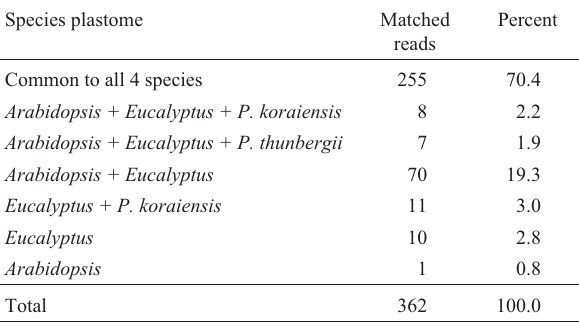
Table 2 - Number of Citrus sequences (reads) with significant positive match with the complete chloroplast genome sequences from four species